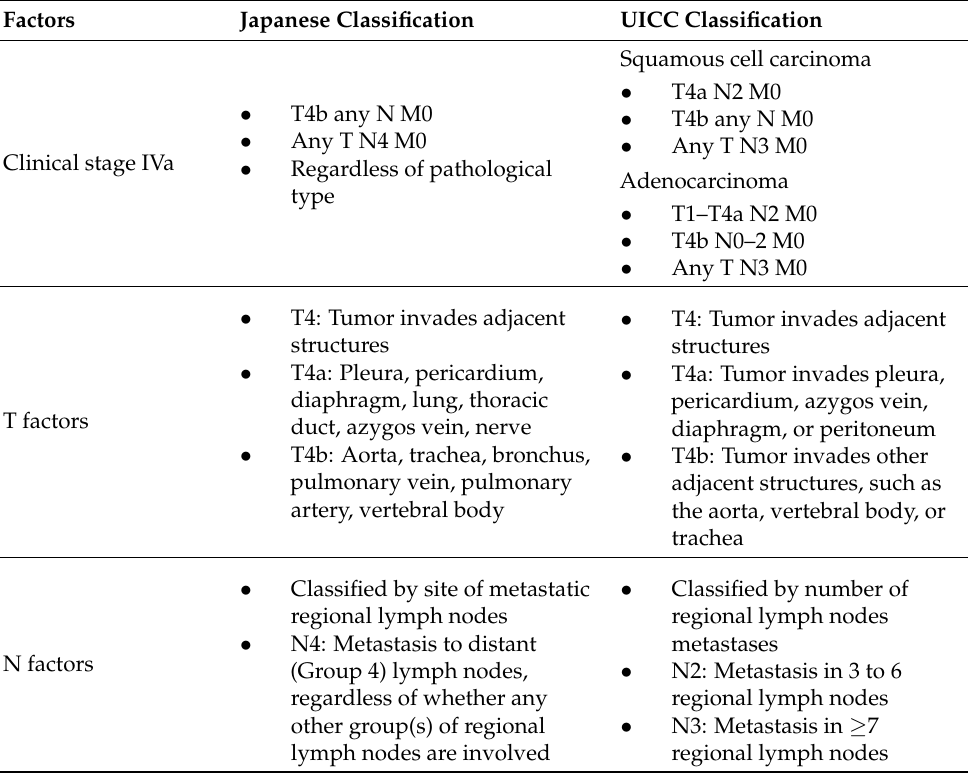
Table 1. Japanese Classification of Esophageal Cancer and Union For International Cancer Control (UICC) tumor, node, metastasis (TNM) classification of malignant